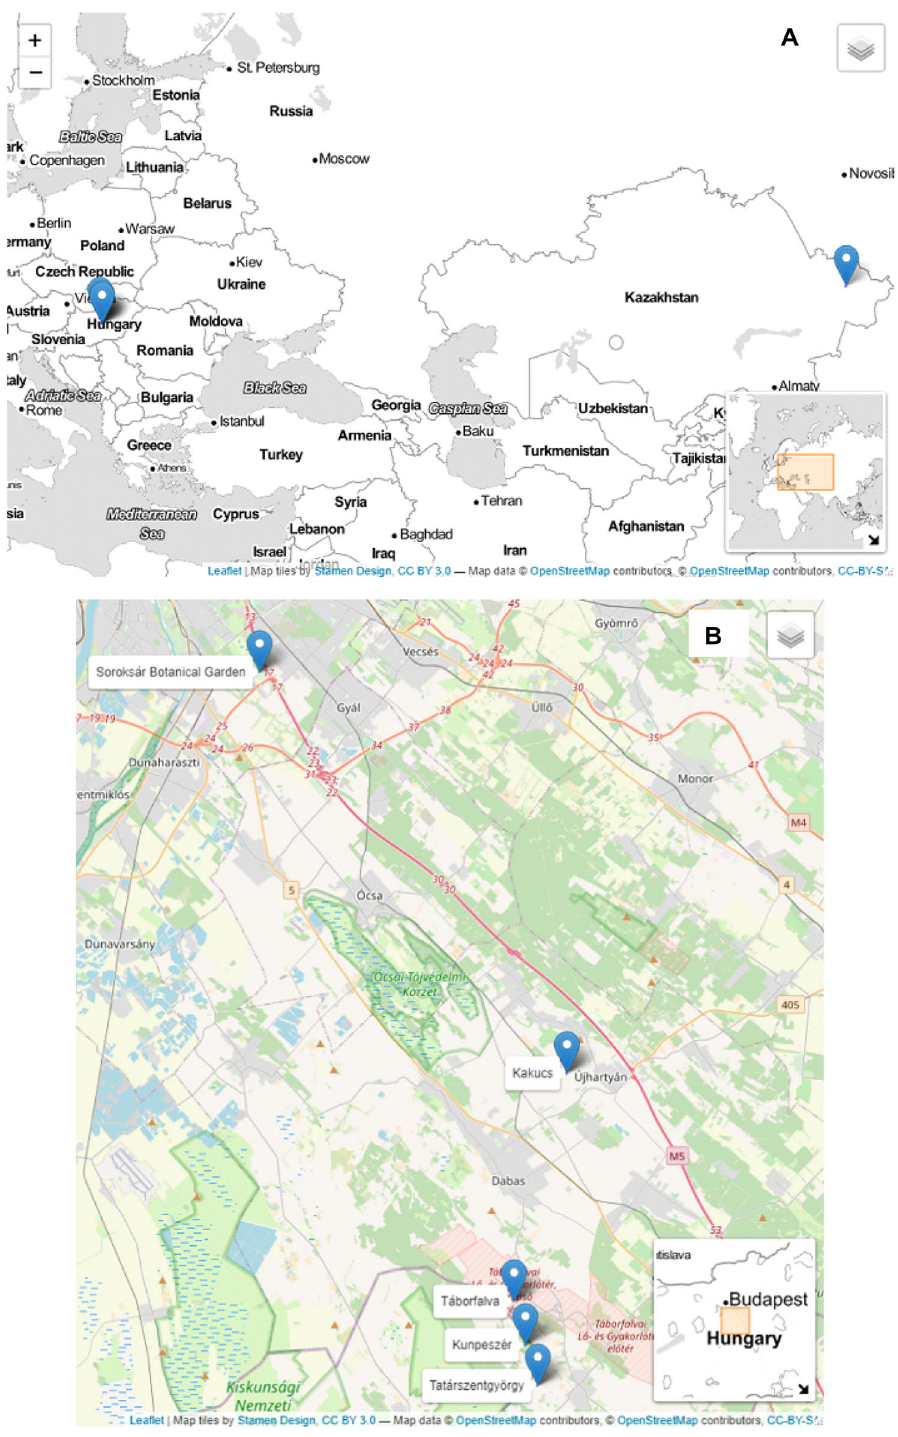
Fig. 1 The map of the sampled populations of Plantago maxima in Hungary and Kazakhstan ( A ). The Hungarian localities are presented in better resolution B in a terrain map (source: https:// rstud io. github. io/ leafl